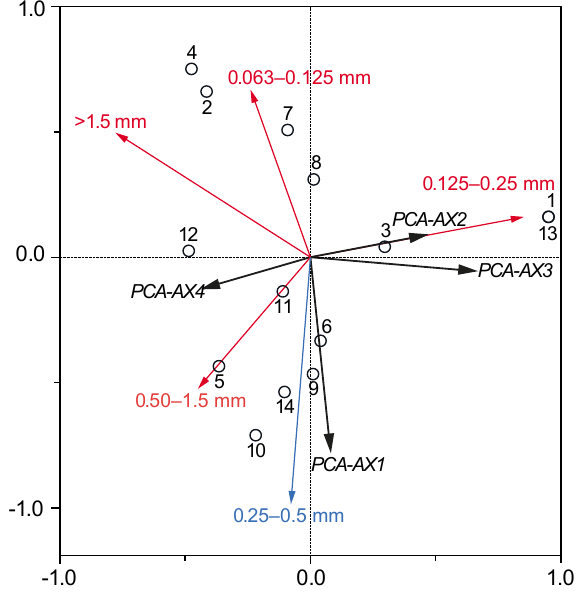
Figure 5. RDA plot showing the total foraminiferal thanatocoeno- sis against grain size. Sample sites are indicated by a black circle as well as by site number (GH12-01 to GH12-14). Sample sites 1 and 13 showed identical scoring. The foraminiferal fauna is statistically divided into four PCA axes (PCA-AX1, PCA-AX2, PCA-AX3 and PCA-AX4) illustrated as black vectors. Grain size fractions in mil- limetres are shown as red and blue vectors; only the 0.25–0.5mm fraction (shown as the blue vector) was significant for the faunal variation in the foraminiferal thanatocoenosis.